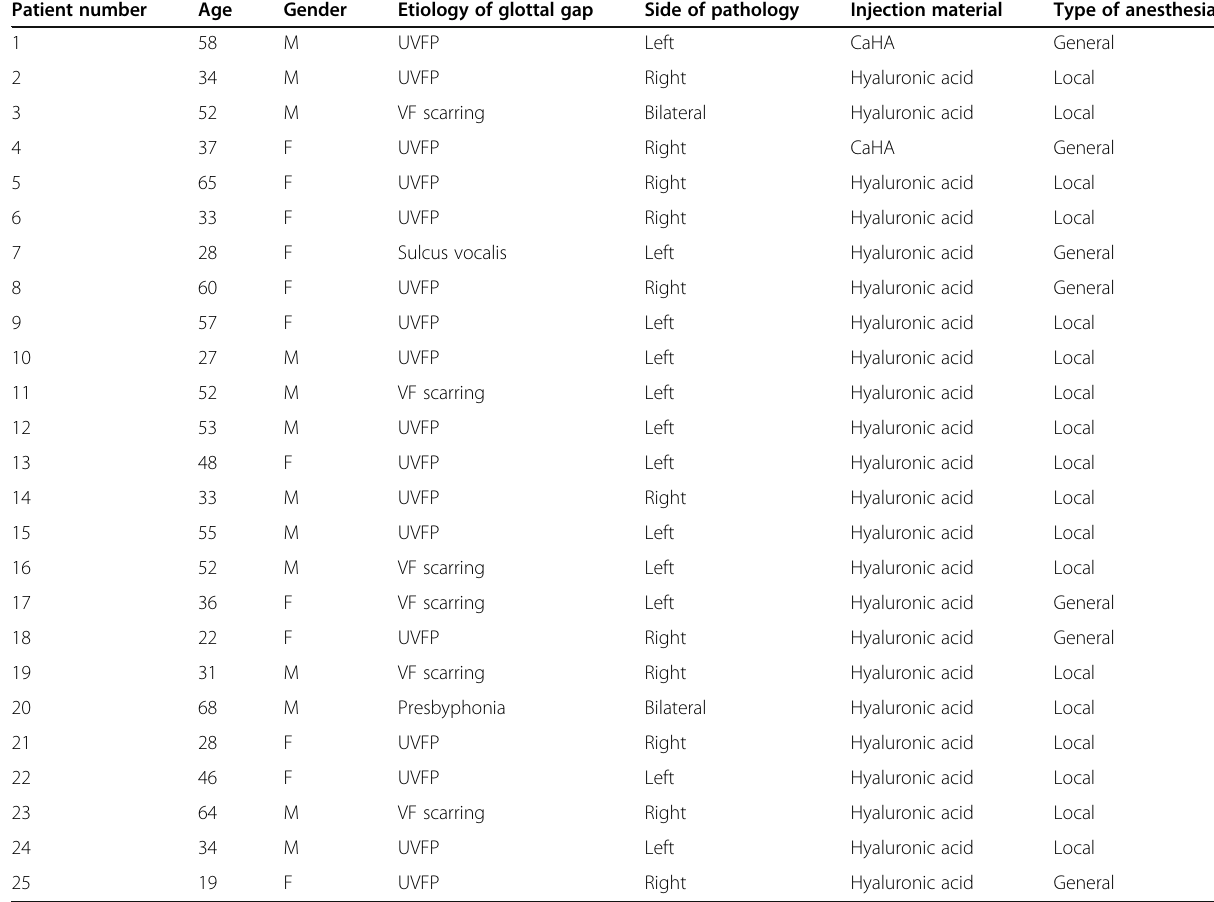
Table 1 Descriptive data for patients enrolled in the study ( n = 25) Patient number